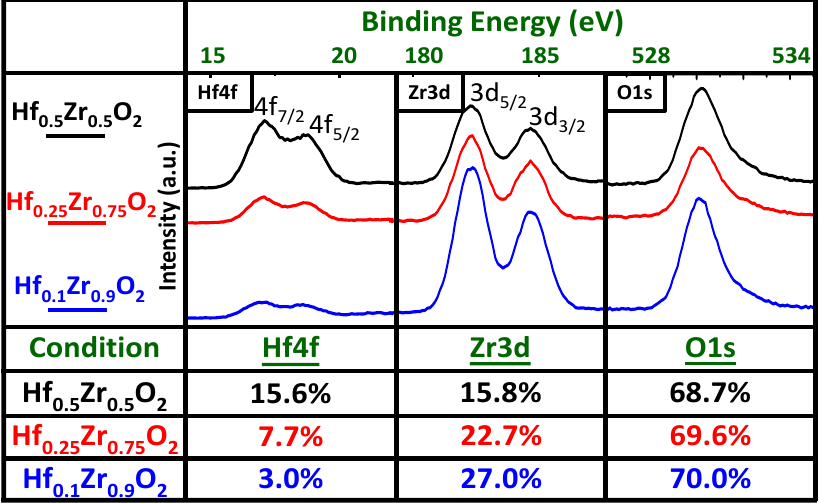
Figure 3. The XPS of the HZOs for Hf:Zr at 15.6:15.8 ([Zr] = 50%), 7.7:22.7 ([Zr] = 75%), and 3:27 ([Zr] = 90%). The Hf:Zr in the HZOs spectra agrees with the nominal ALD cycle ratio.